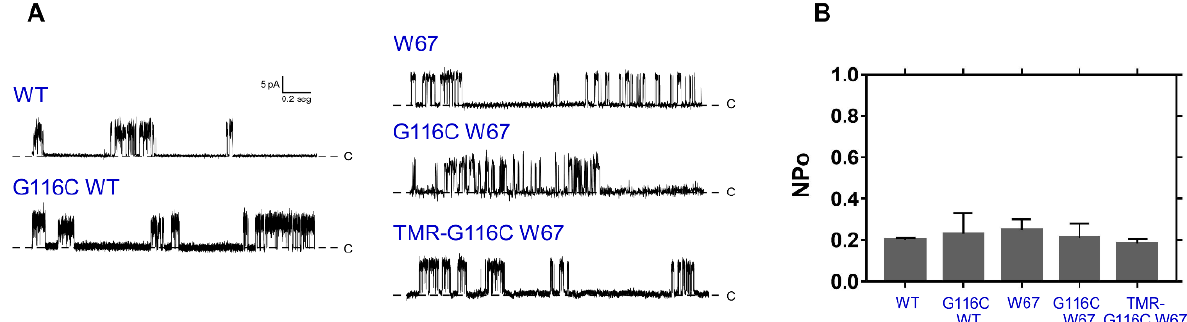
Figure 3. The mutation G116C and its conjugation to TMR does not impact on the functional properties of the wild-type (WT) and W67 KcsA channels. ( A ) Inside-out patch-clamp recordings in continuous mode at +150 mV of WT [12], G116C WT, W67 [12], G116C W67 KcsA, and TMR-labeled G116C W67 KcsA (dye-to-protein molar ratio, D:P = 0.45) channels reconstituted in asolectin liposomes (10 mM HEPES, 100 mM KCl at pH 7.0). The baseline (dashed lines) indicates the closed channel state (closed, C). Channel openings appear as upward deflections over the closed state line. The WT and G116C WT protein showed the expected behavior previously reported in the literature [43,44]. ( B ) The open channel probability, NP o is presented as the average ± SD of at least three independent experiments.